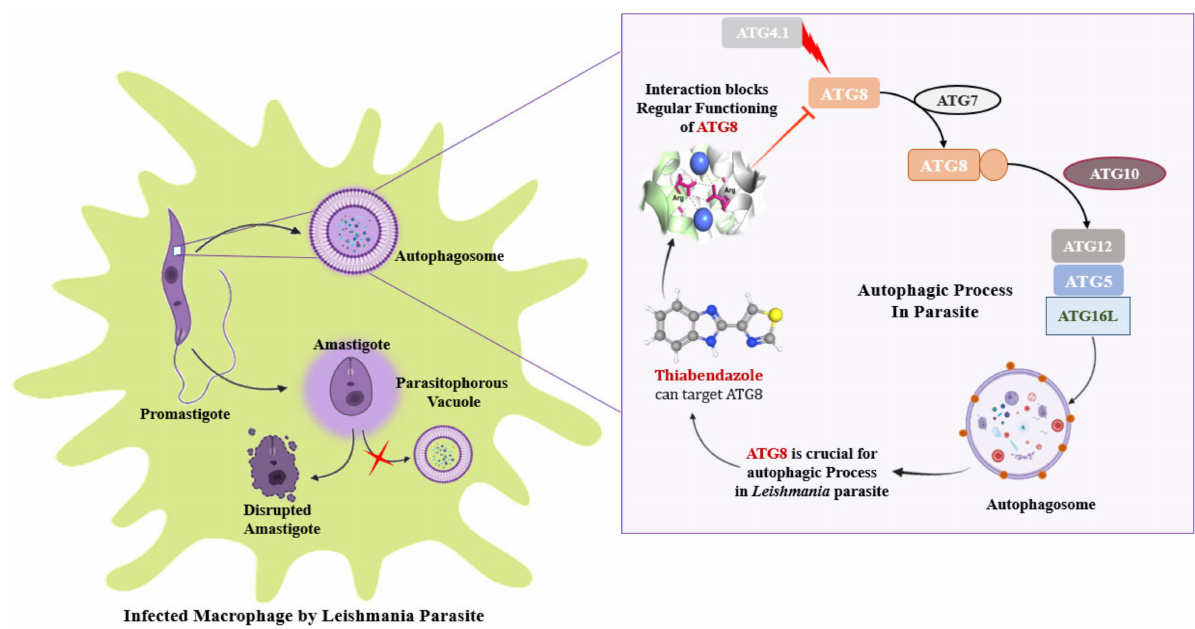
Figure 10. Illustrating the importance of ATG8 in Leishmania parasite, which is crucial for autophagic process. After binding with the Thiabendazole molecule, regular functioning of ATG8 can get hampered.